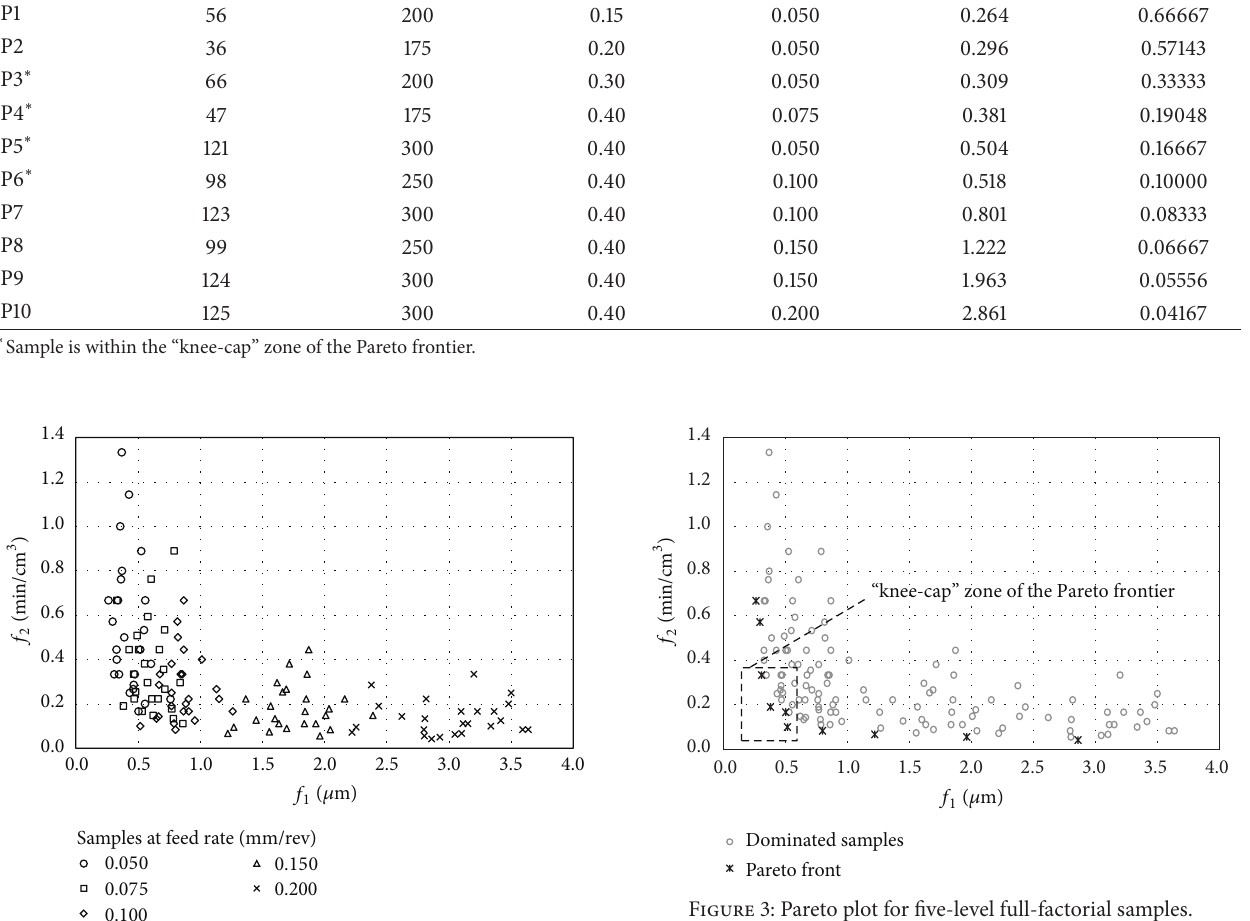
Figure 2: Objective values for five-level full-factorial samples.